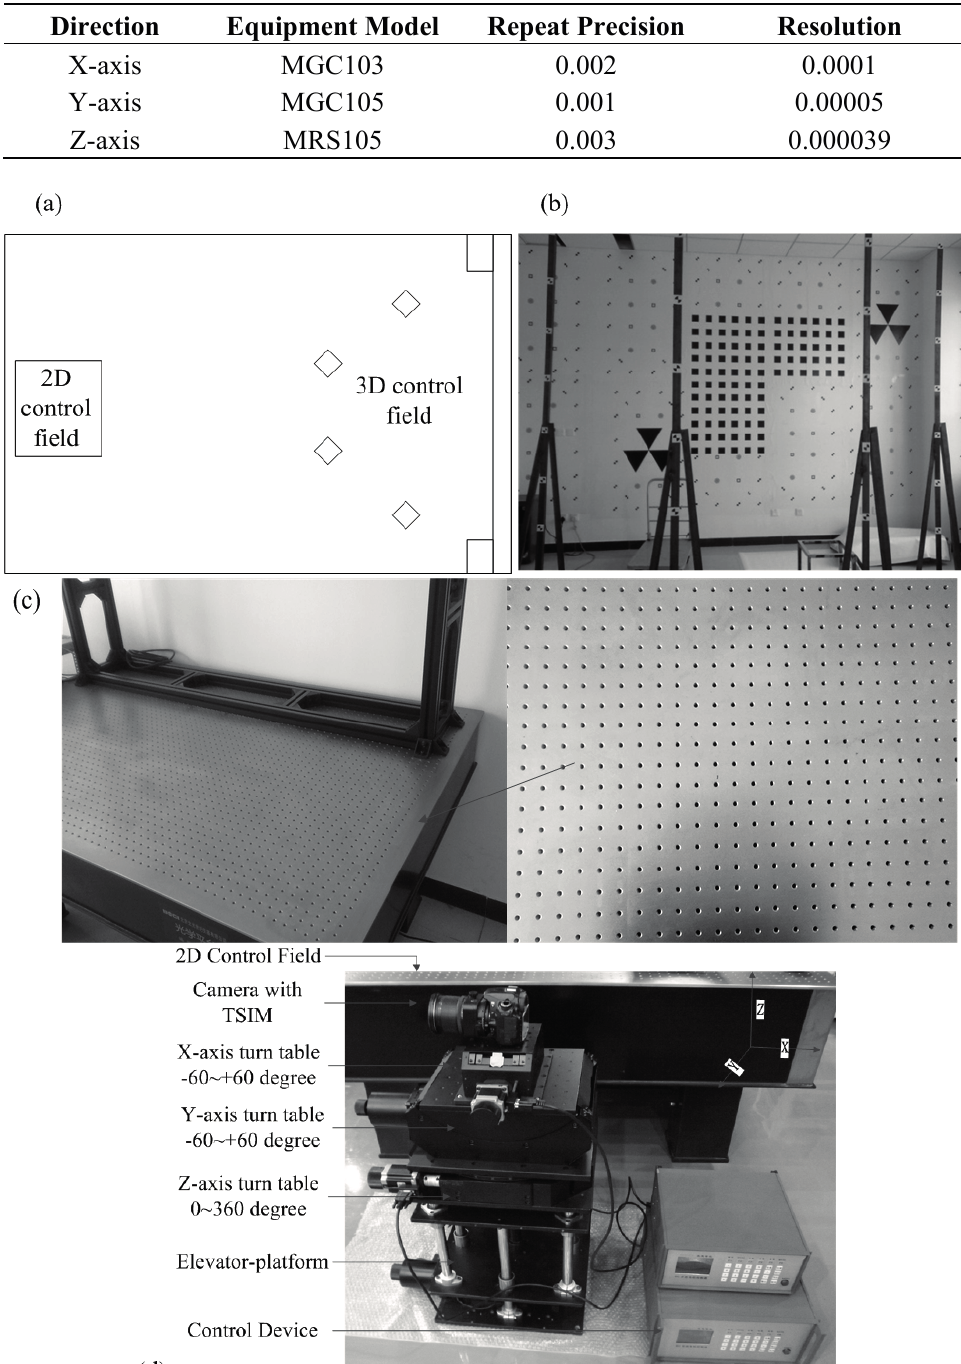
Table 3. Precision of each turntable ( ° ).